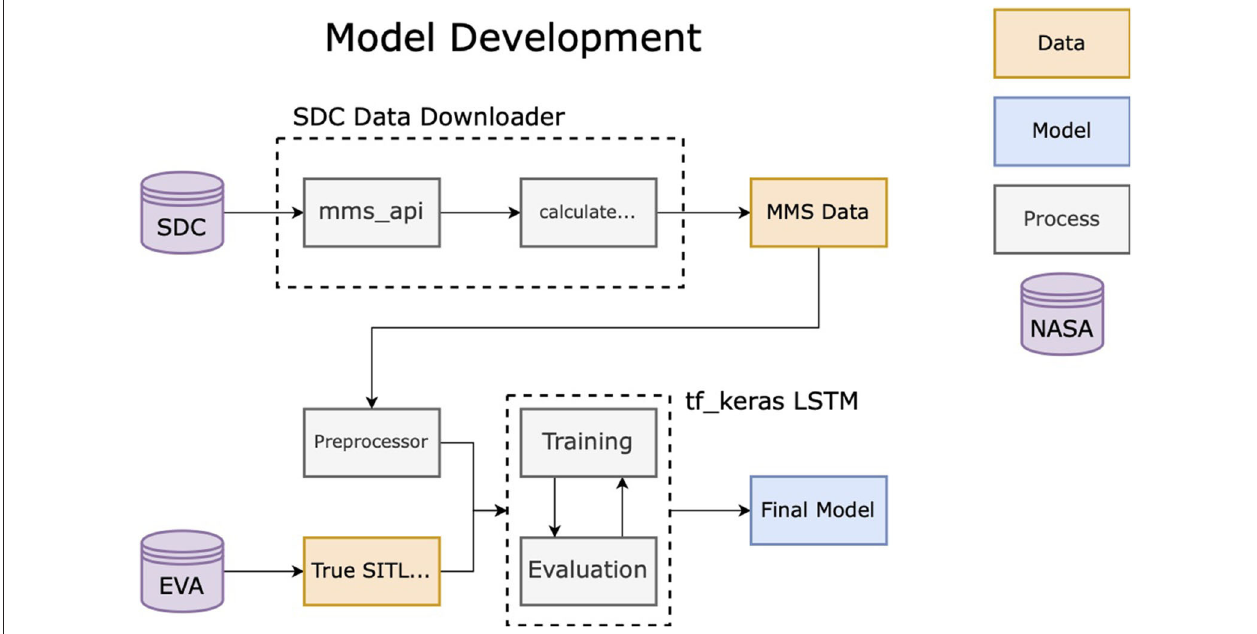
FIGURE 1 | The GLS magnetopause model is an example of a supervised learning model that made use of data labeled previously by the SITL for training and testing. Applying historical SITL labels to preprocessed data significantly reduce the time needed for model